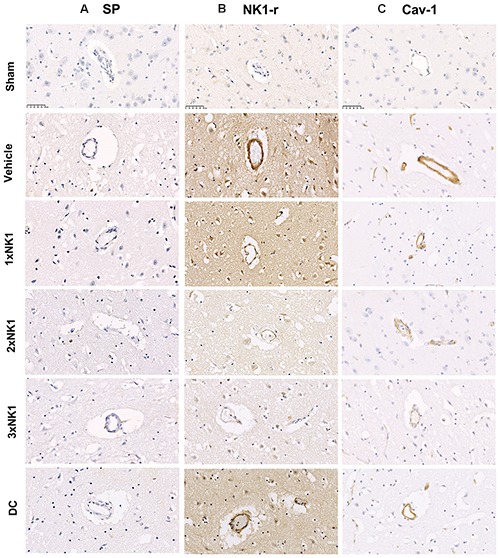
SP, NK1-r and caveolin-1 immunoreactivity. There was no identifiable increase in SP, NK1-r or cav-1 immunoreactivity in sham animals. Low levels of SP immunoreactivity were seen perivascularly in vehicle, 1×NK1, 2×NK1, 3×NK1 and DC groups (A). This was concordant with an increase in NK1-r immunoreactivity, which was most prominent in vehicle, 1×NK1 and DC animals (B). Cav-1 immunoreactivity was significantly enhanced in 1×NK1, 2×NK1 and DC treatment groups when compared to vehicle and 1×NK1 (C). Scale bar: 50 μm, 40× magnification.